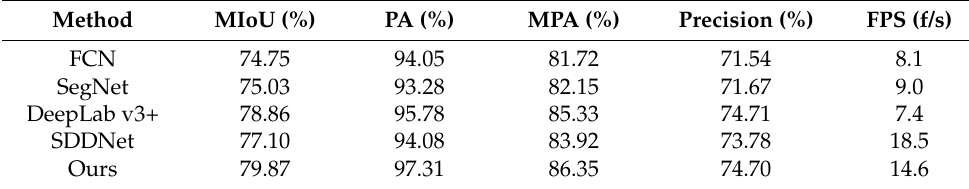
Figure 9. The MIoU, PA and MPA of the proposed EMA-DenseNet on our bridge damage dataset during each iteration, the solid lines indicate the proposed networks with EMA module, and the dotted lines represent networks without EMA modules. Table 3. Comparison of Performance for Different Methods on Bridge Damage